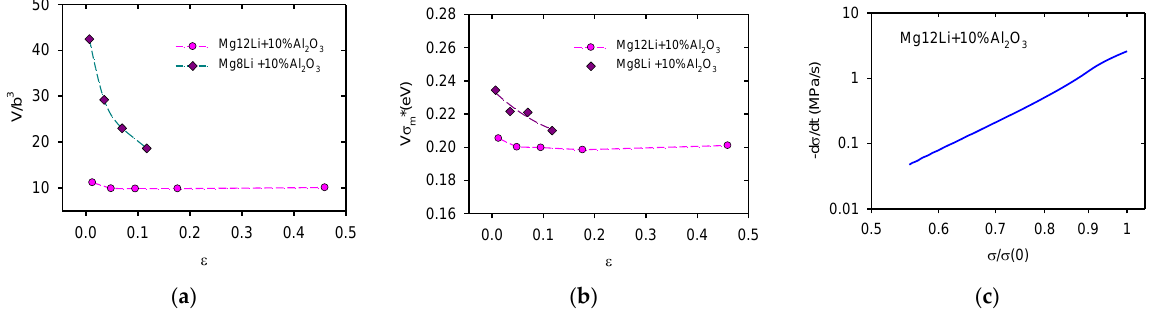
. σ vs. σ / σ (0) is in the